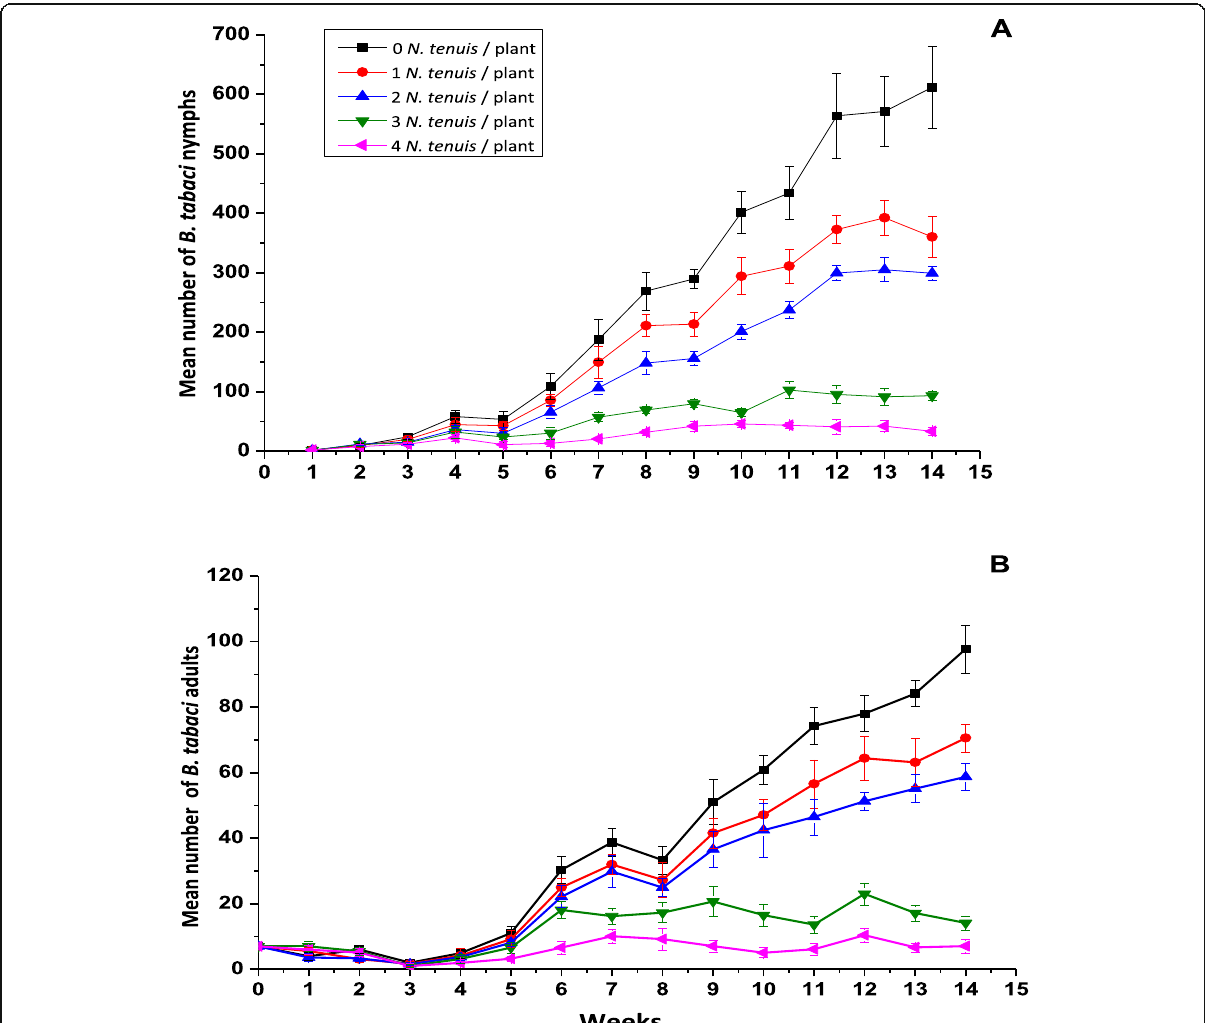
Fig. 1 Mean (±SD) number of Bemisia tabaci nymphs and adults as a function of treatment concentrations with (0, 1, 2, 3, and 4) Nesidiocoris tenuis nymphs per plant for 14 weeks ( a nymph population, b adult